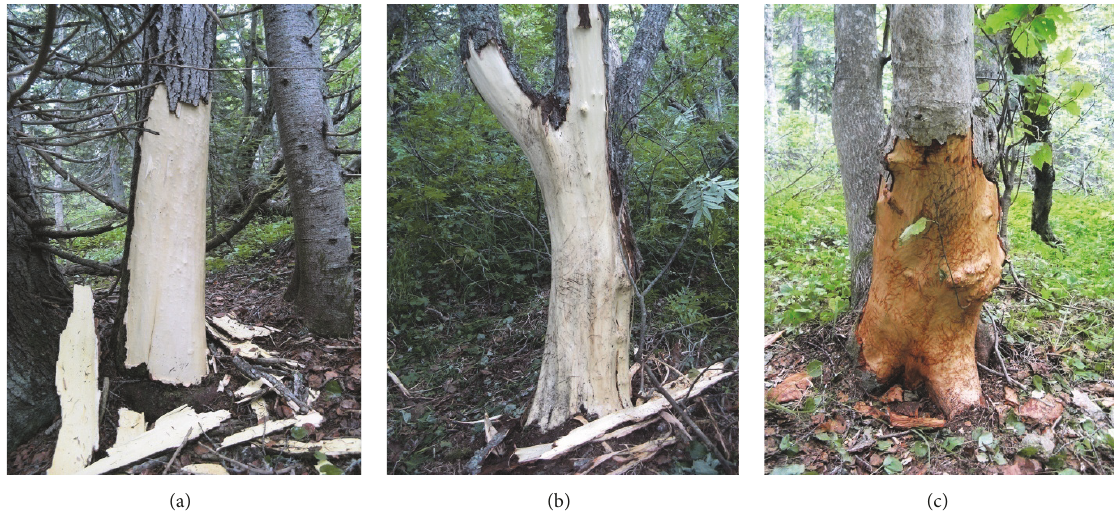
Figure 3: Deciduous trees, bark stripped by bears to get the cambium in Sakhalin Island: (a) Populus tremula , (b) Salix caprea , and (c) Alnus hirsute